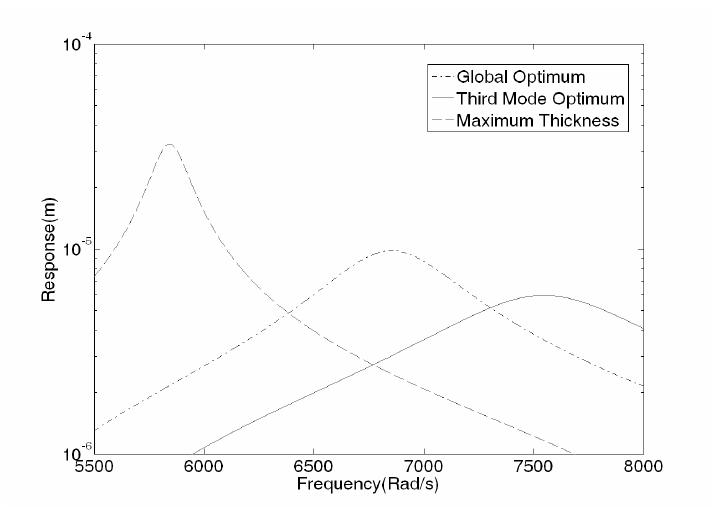
Fig. 14. Comparsion between the local optimum configuration in the third mode, the overall optimum configuration and the configuration with maximum thickness of damping layer and constraining layer. The visco and constraining layer thicknesses for the local optimum are 0.0001 m and 0.002 m, and for maximum thickness configuration are 0.002 m and 0.002 m,